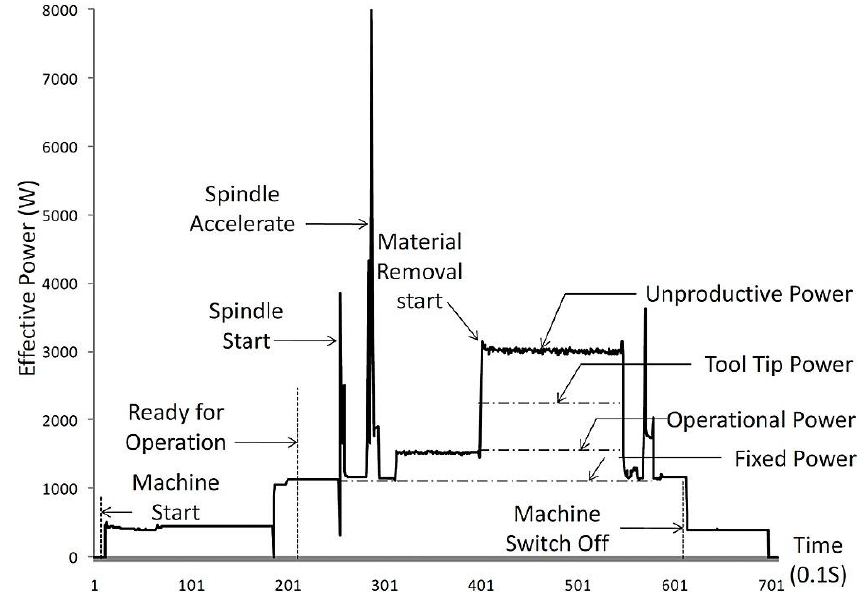
Figure 2. Machine tool power usage in a complete machining process.